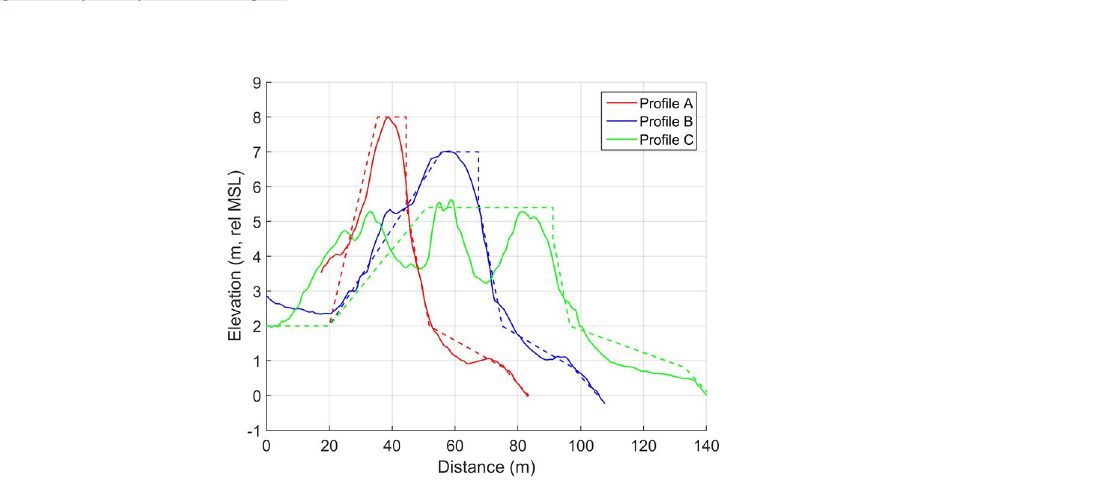
Fig 10. Profiles from DEM dated 12/04/2010, dashed lines display model schematization of the dune.